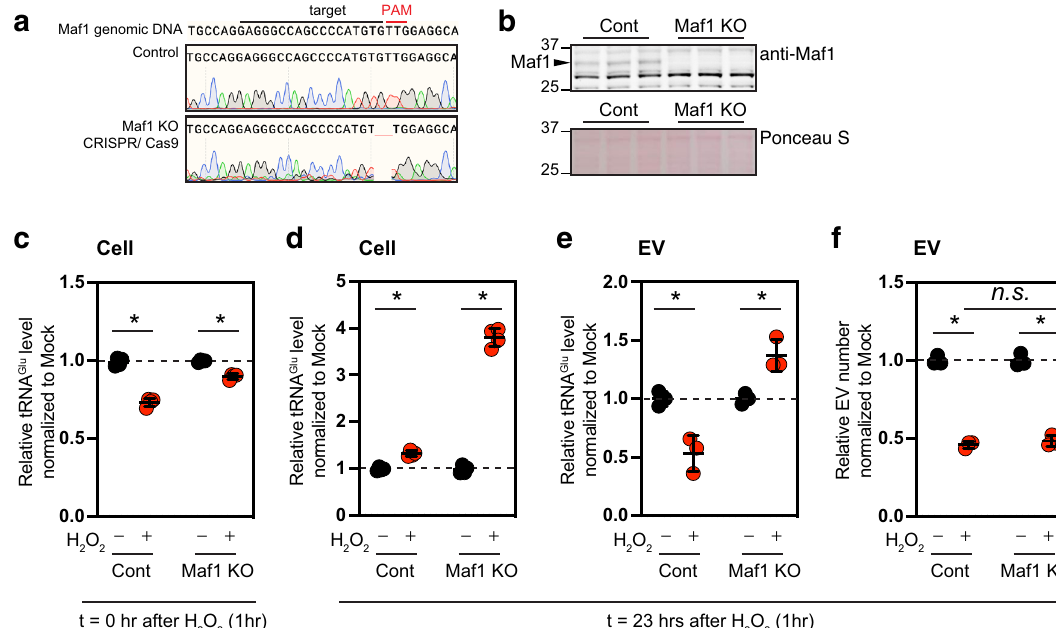
Figure 4. Maf1-mediated transcriptional repression in extracellular release of vesicle-loaded RNA Glu under oxidative stress. ( a ) Sanger sequencing of the Cas9/CRISPR-targeted Maf1 locus. The sequencing chromatograms of sgRNA target region indicate homozygous status of the Maf1 locus in Maf1 knockout (KO) cells. ( b ) Immunoblotting analysis with anti-Maf1 confirms the loss of Maf1 expression in BUMPT cells. Ponceau S staining was used to determine equal amounts of proteins loaded per lane. ( c – e ) Changes in abundance of intracellular (cell) and extracellular vesicle (EV) tRNA Glu in control and Maf1 knockout (KO) cells treated with 0.1 mM of H 2 O 2 at the indicated timepoints. To collect conditioned media after oxidative stress, cells were treated with H 2 O 2 for 1 h and thereafter exposed to serum-free, H 2 O 2 -free growth media for 23 h. Expression levels of tRNA Glu were normalized to total RNA amount, and then relative expression values of tRNA Glu of treated group normalized to control group were plotted. Because transient oxidative stress resulted in significant changes in total RNA levels and U6 snoRNA (not shown), relative expression of tRNA Glu was normalized in this manner (cell number and conditioned media volume). For extracellular vesicle samples, benzonase was treated as described in “Methods” section. ( f ) Relative number of extracellular vesicles from control and Maf1 knockout (KO) cells under oxidative stress. Cells were treated as in ( c – e ). Note that transient oxidative stress decreases release of extracellular vesicles ( number ) regardless of the status of Maf1